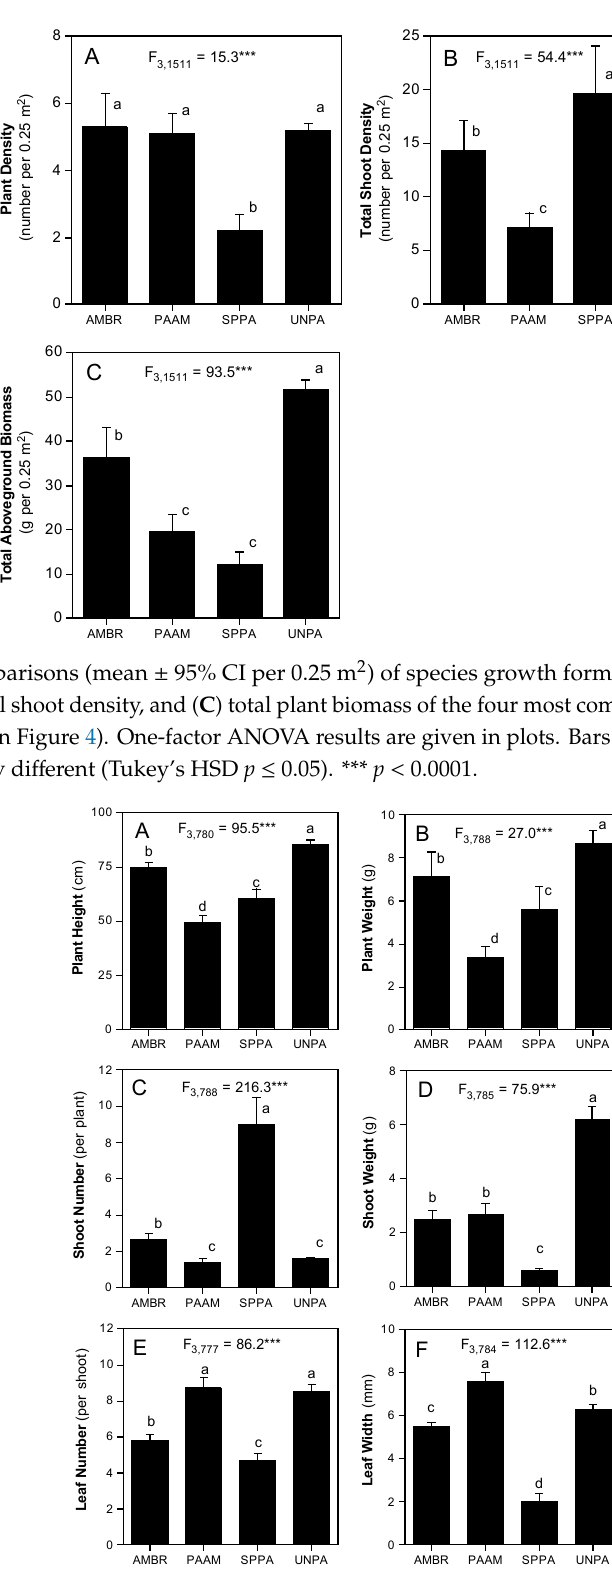
Figure 7. Comparisons (mean ± 95% CI) of plant morphology, including ( A ) plant height, ( B ) plant weight, ( C ) shoot number, ( D ) shoot weight, ( E ) leaf number, and ( F ) leaf width of the four common dune grass species (abbreviations in Figure 4). One-factor ANOVA results are given in plots. Bars that do not share letters are significantly different (Tukey’s HSD p ≤ 0.05). *** p < 0.0001.